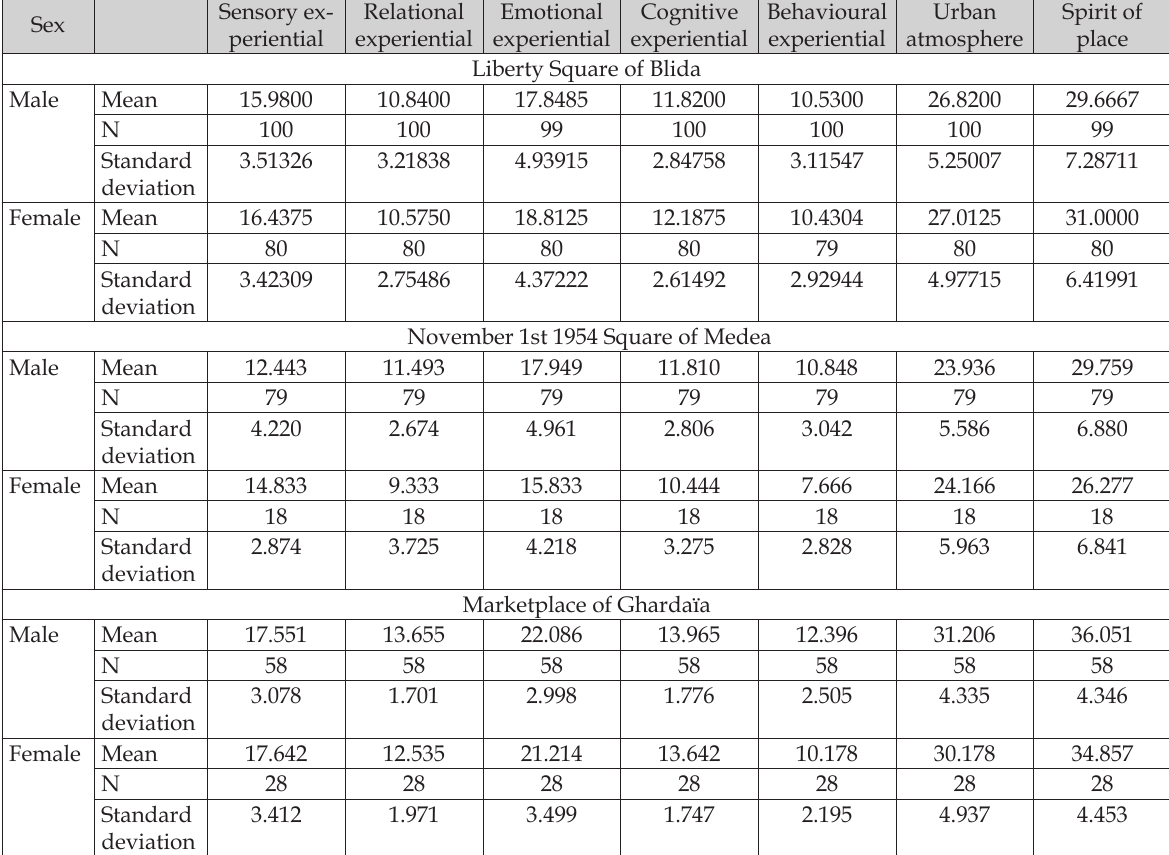
Table 4. Statistical description by gender category.